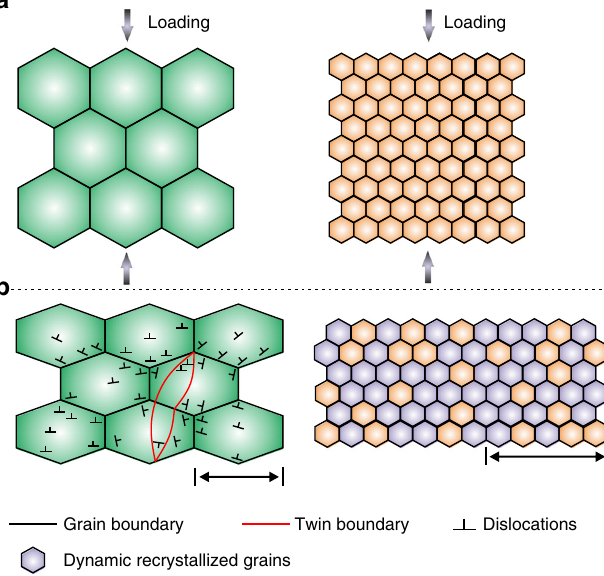
Fig. 5 Deformation modes in coarse-grained and fi ne-grained specimens. Schematic diagrams showing microstructure a before, and b after compression at room temperature. The dominant deformation mechanism is intra-granular dislocation slip and twinning in a coarse-grained microstructure that is produced by 400 °C extrusion, and inter-granular mechanisms (grain boundary sliding, which is accommodated by grain rotation, and dynamic recrystallisation) in a fi ne-grained microstructure resulting from near room temperature extrusion. Scale bars for coarse- grained and fi ne-grained microstructures indicate ~80 and ~5 µ